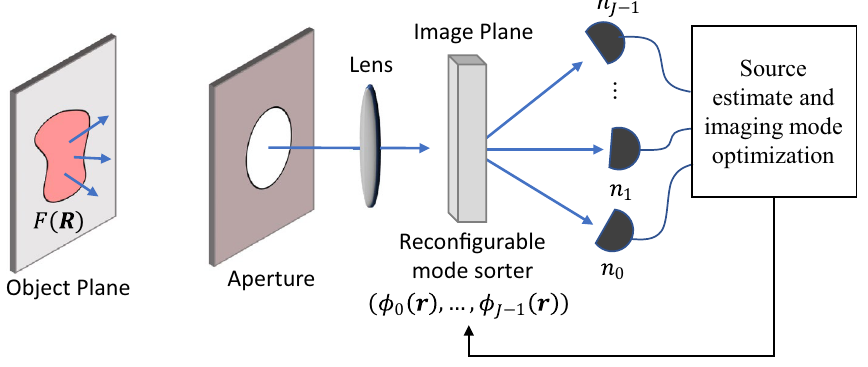
Figure 1. Adaptive spatial mode imaging system. Light from the far-field source distribution F ( R ) is captured by a hard aperture and imaged onto a spatial mode sorter of imaging modes (cid:31) . At each measurement iteration, the number of photons detected in each channel n j is used to generate a source estimate, as well as an updated set of optimal spatial imaging modes for the next measurement